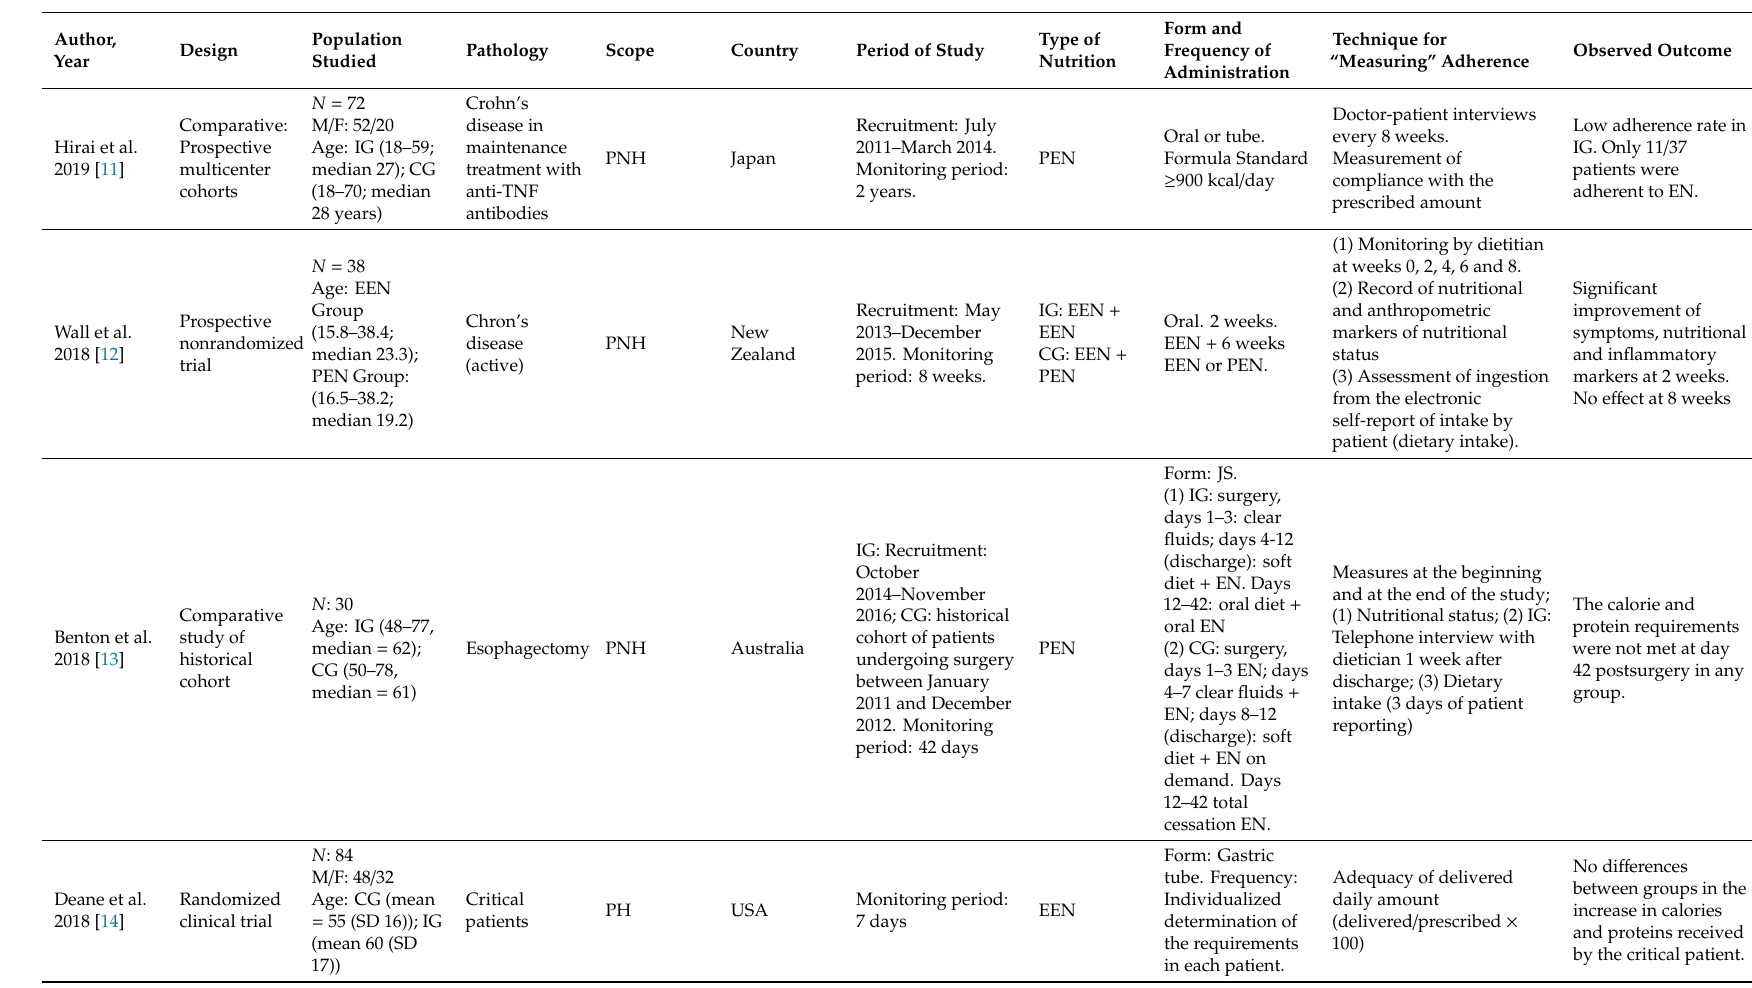
Table 1. Summary of the studies reviewed on compliance and adherence to enteral nutrition in